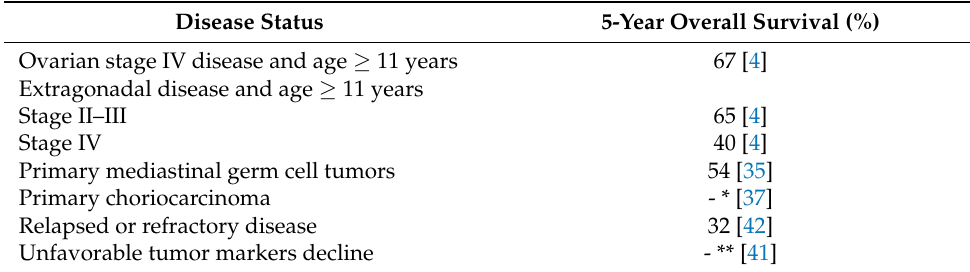
Table 1. Poor prognosis of germ cell